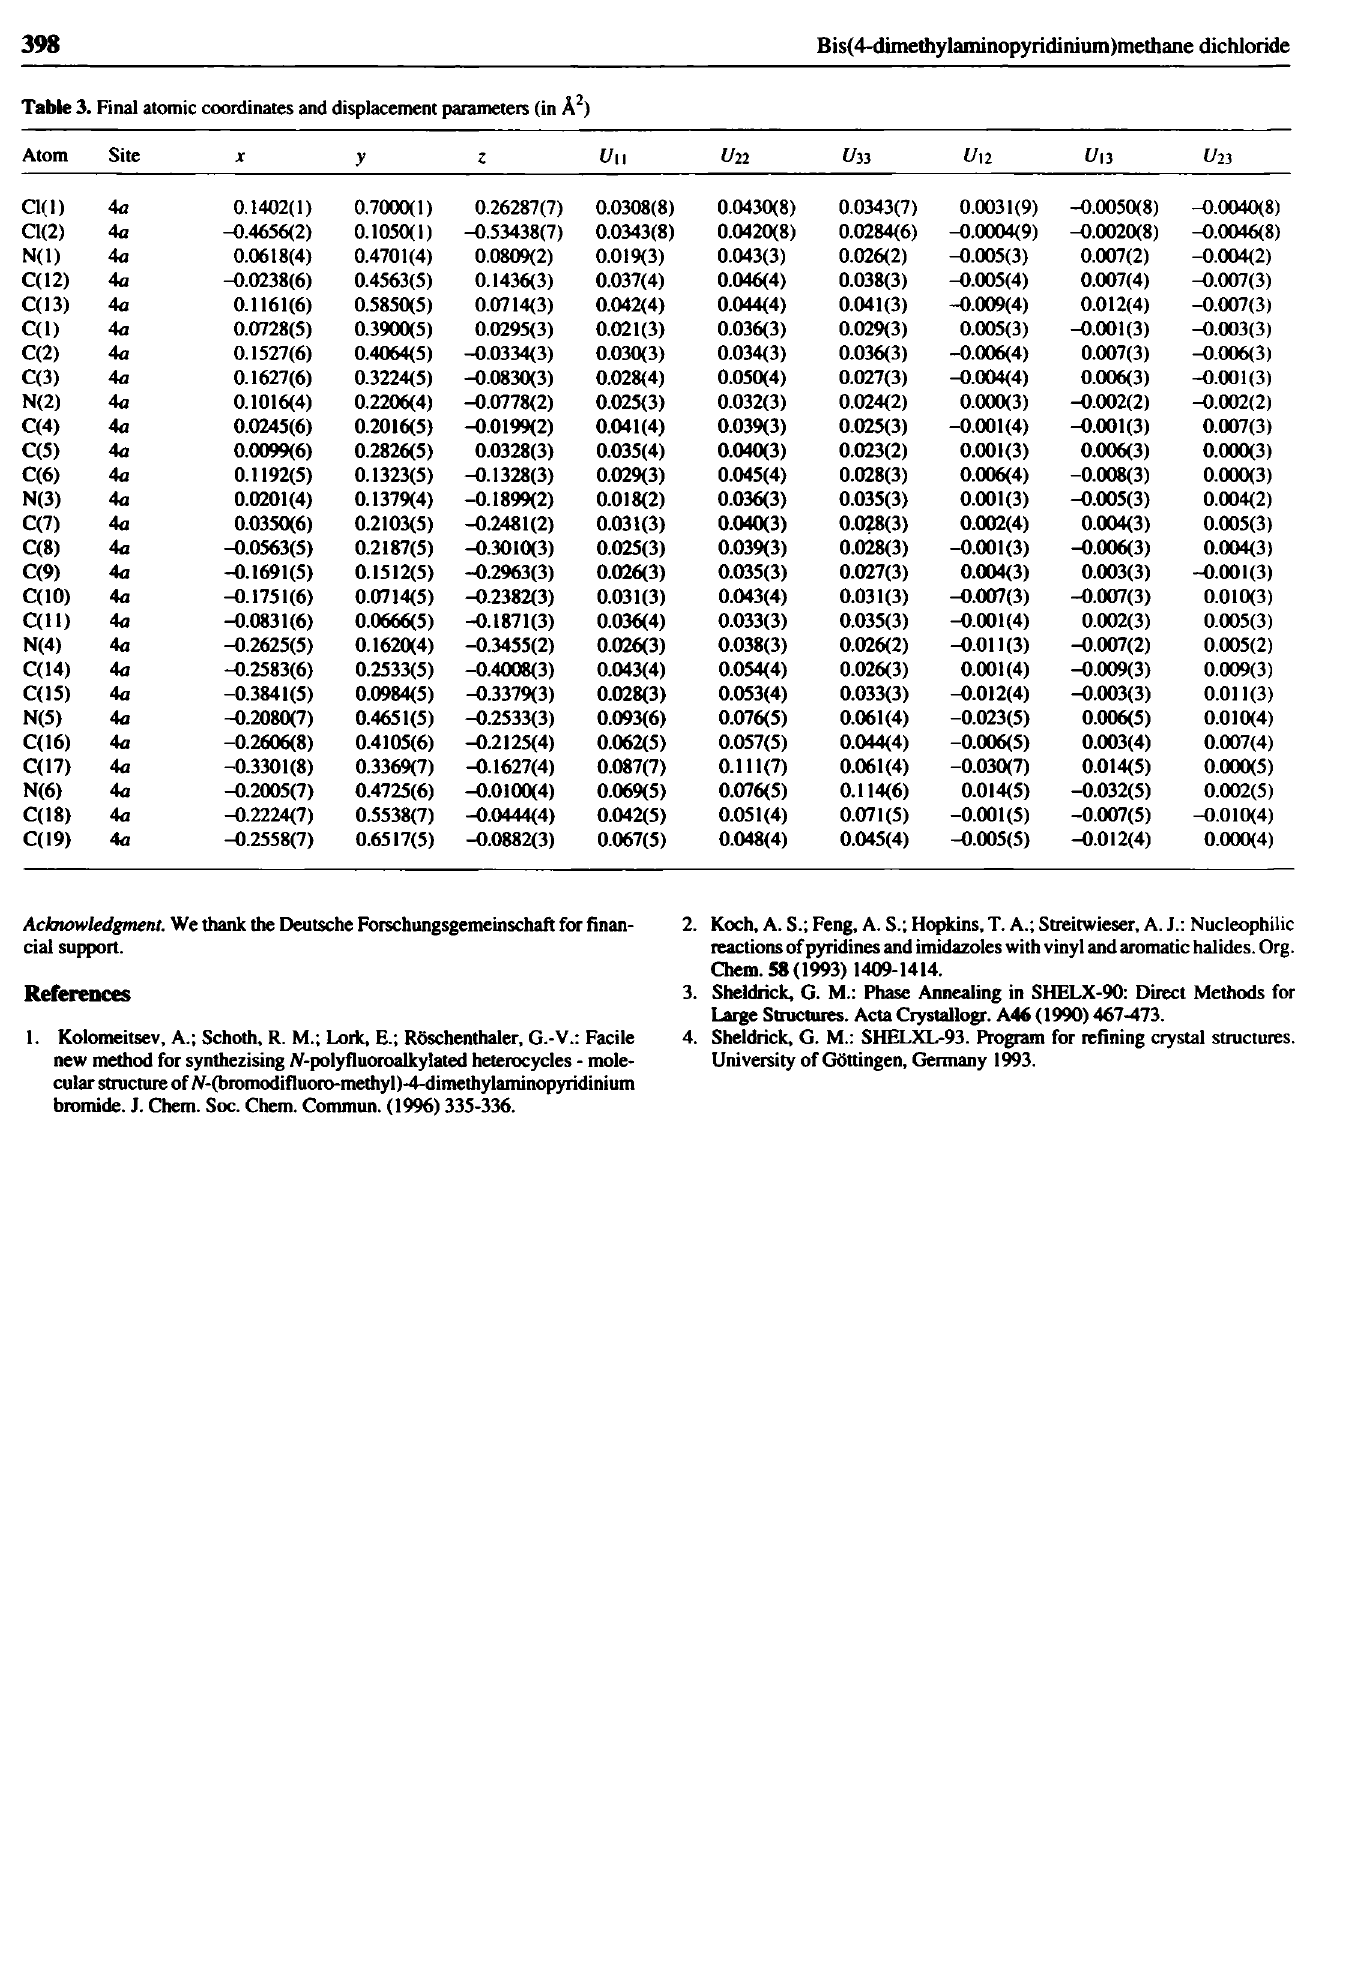
Table 3. Final atomic coordinates and displacement parameters (in Â 2